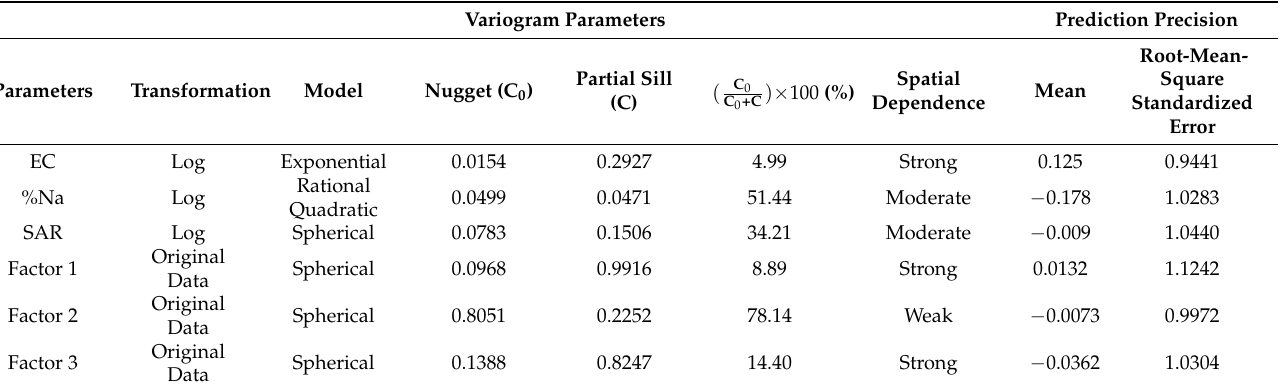
Table 5. Best-fitted semi-variogram models and cross-validation for OK of groundwater irrigation parameters and factors